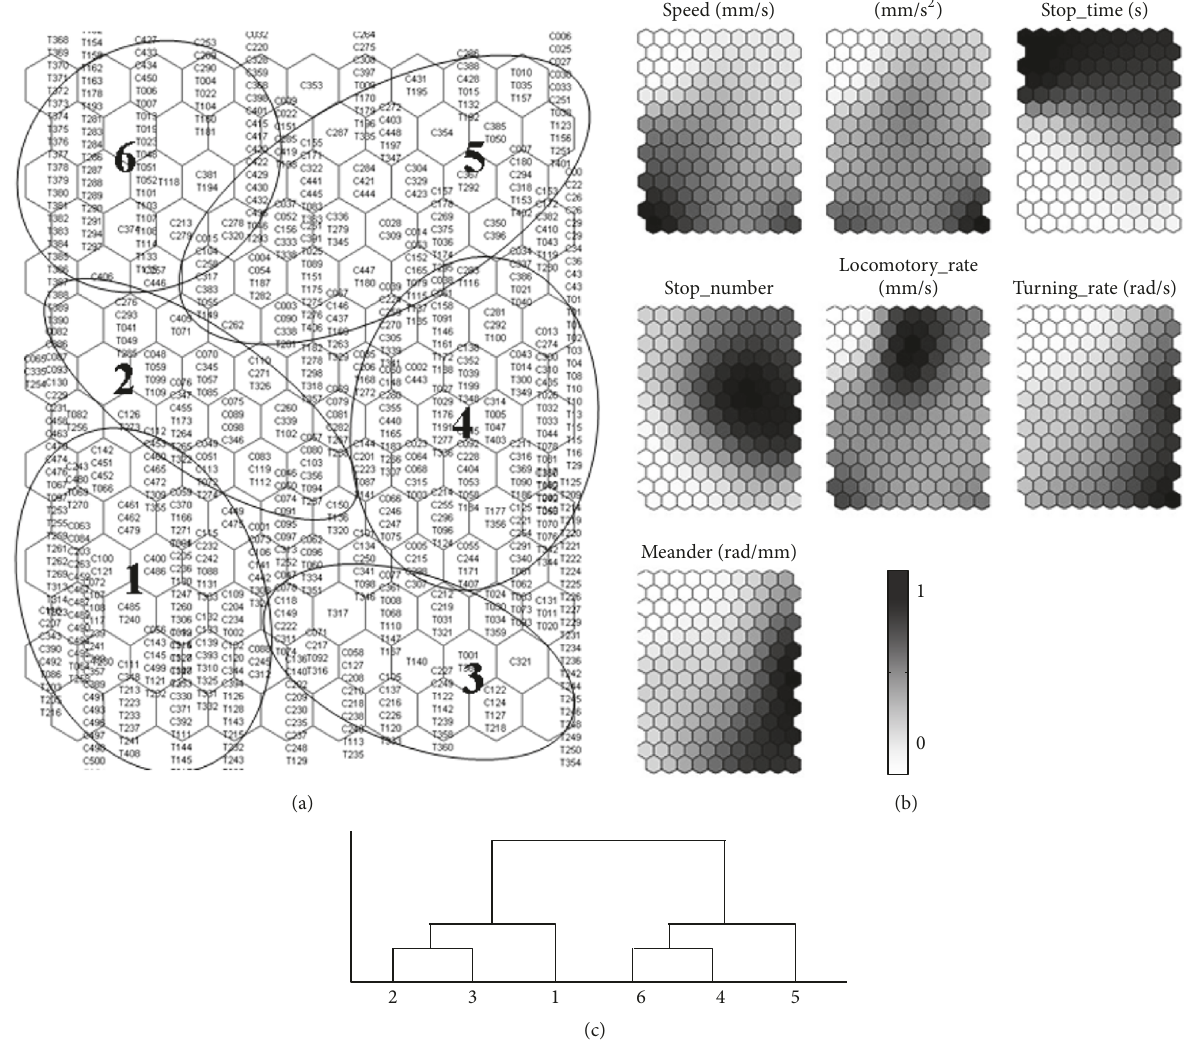
Figure 4: The map trained by using the SOM for pattering movement segments of D. magna in 5s. (a) Six clusters classified by the SOM (“C” represents movement segments before treatments, while “T” stands for movement segments after treatments). (b) Profile of the parameters matching the clusters based on the trained SOM. The values in the vertical bar in the top row indicate normalized parameters. (c) Dendrogram according to Ward’s linkage